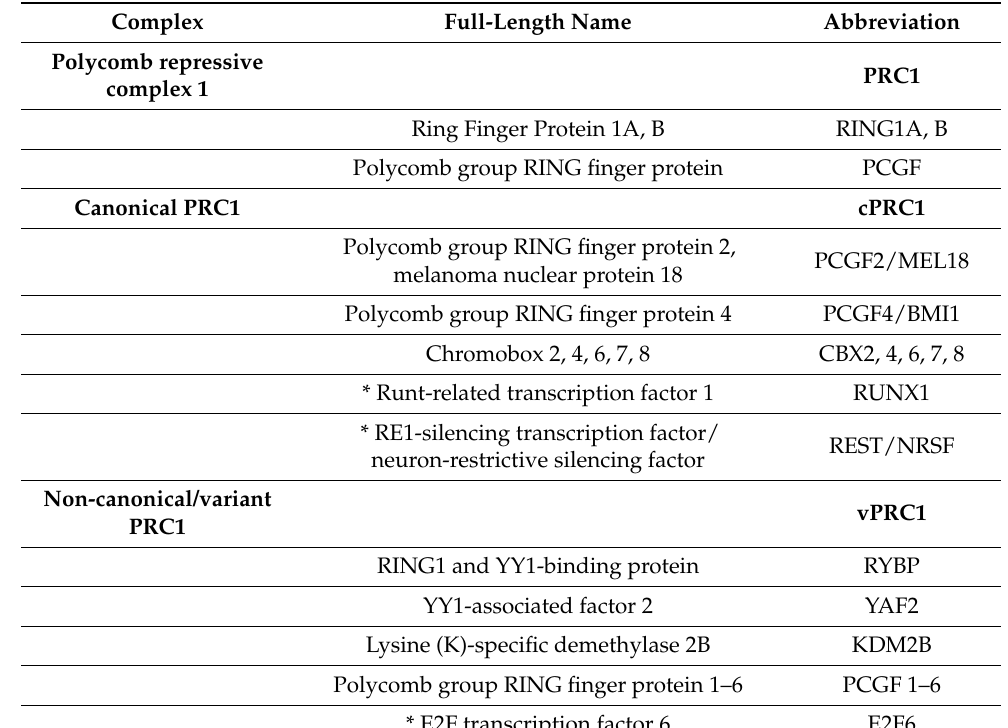
Table 1. Composition and abbreviations used for polycomb-associated